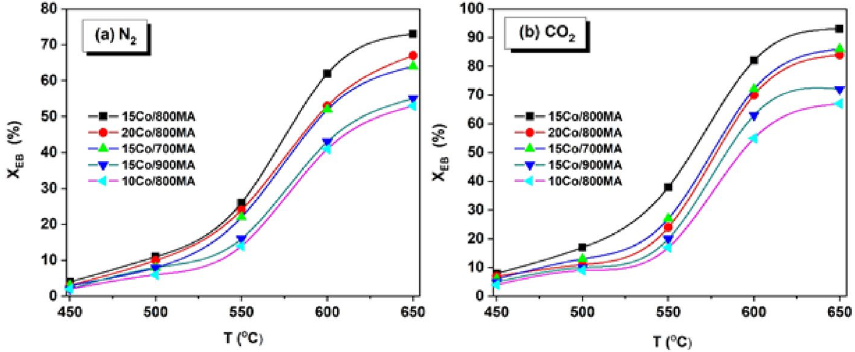
Figure 6. Influence of temperature on EB conversion over Co/MA catalysts under ( a ) N 2 , and ( b ) CO 2 (conditions: T = 450–600 °C, catalyst = 0.7 g, N 2 (or) CO 2 = 30 mL/min, EB = 1.5